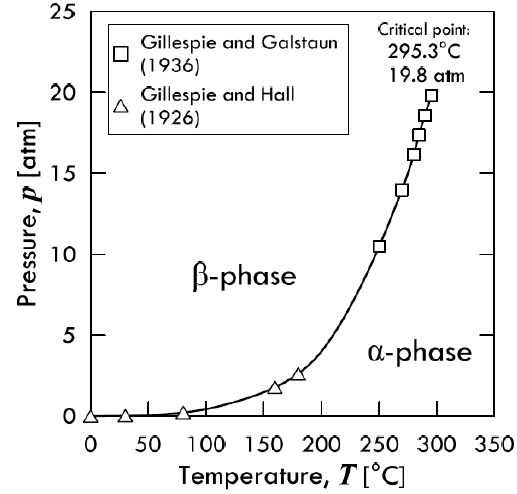
Figure 12. Pressure-Temperature phase diagram for the Pd-H system. Adapted from Jewell et al. [41].